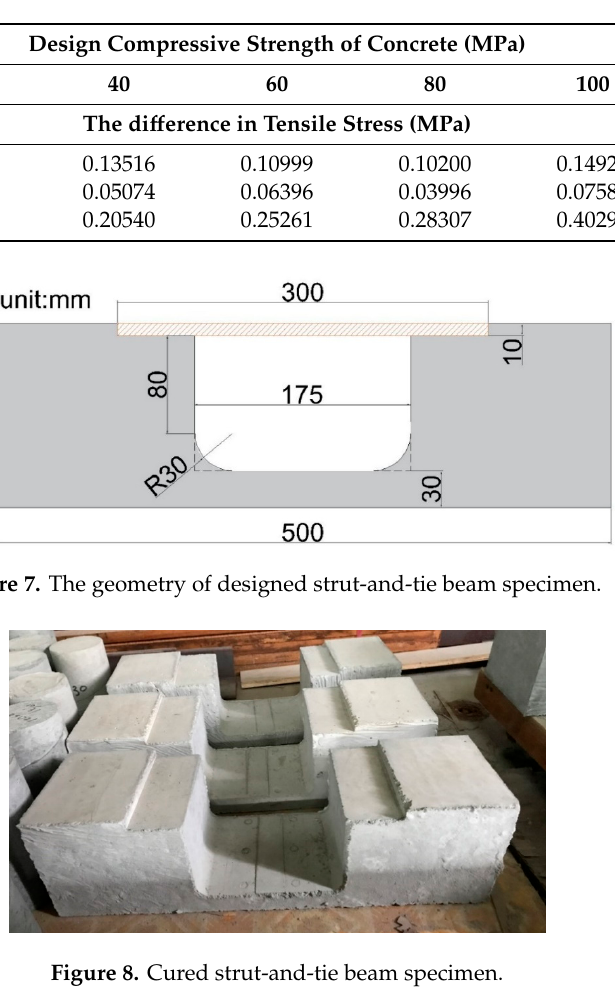
Table 3. Details of mixture proportions (kgf/m 3 ).